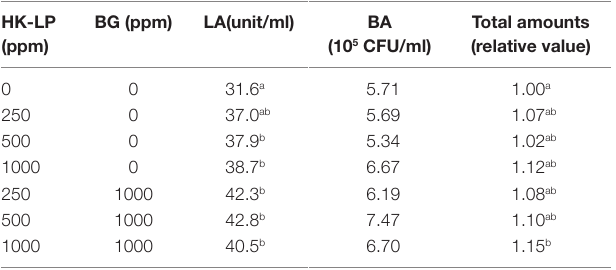
TABLe 1 | Mucus status of red sea bream fed diets containing different levels of heat-killed Lactobacillus plantarum (HK-LP) and β -glucan